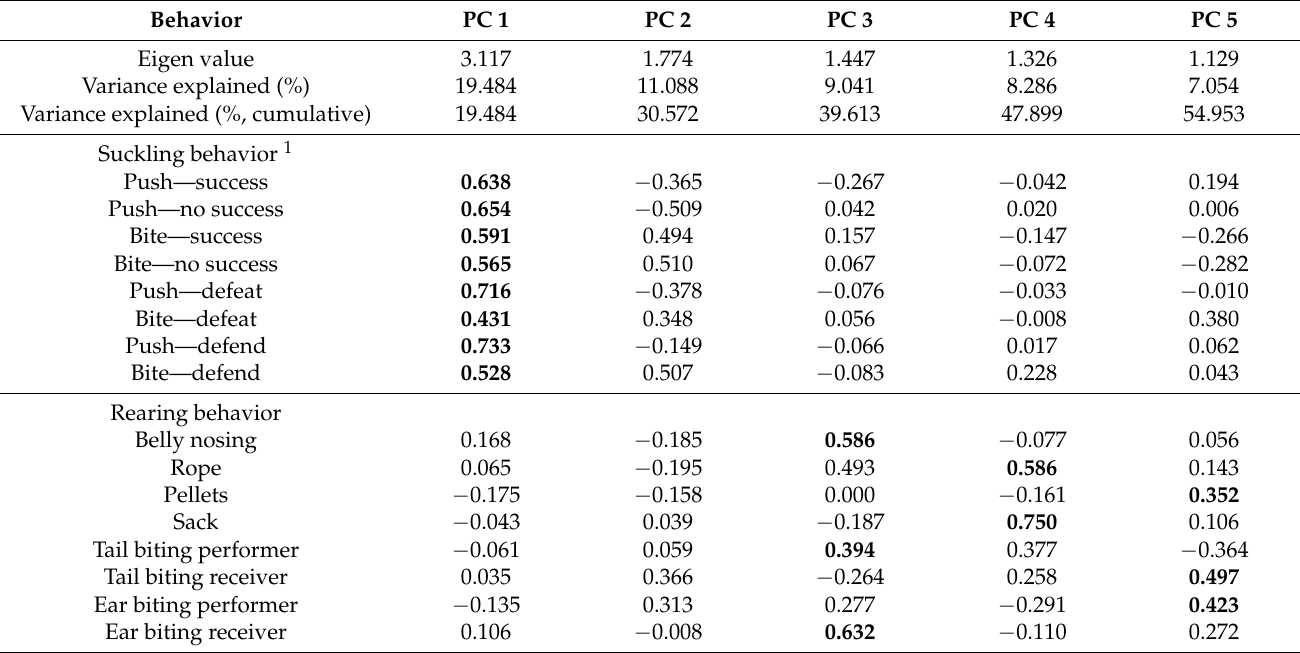
Table 9. Outcomes of the Principal Component Analysis of suckling and rearing behaviors with Eigen value